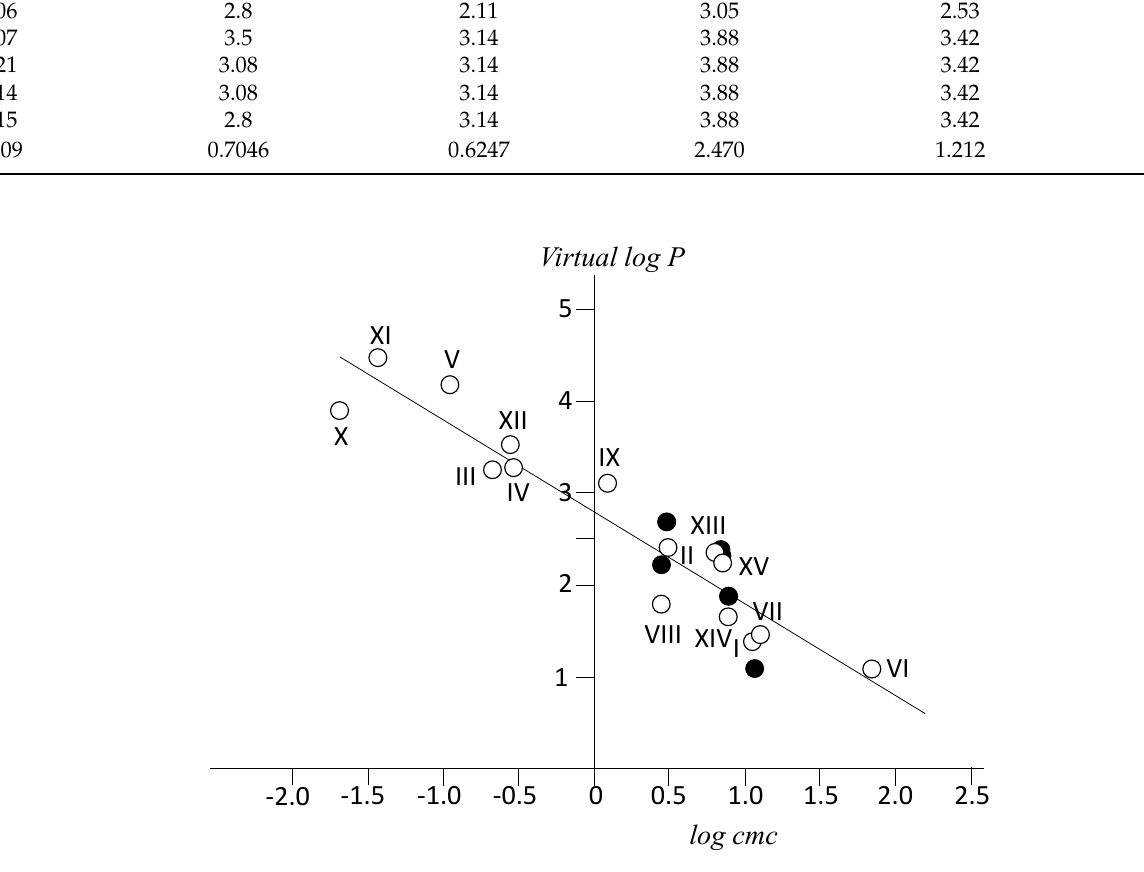
Figure 6. Calculated Virtual log P values vs. experimental log ( cmc/ mM).(Open circles) cmc values for I (NaC) and II (NaDC) from Roda et al. [50]; III (NaAdC), IV (NaAdCH2C), and V (NatbutPhC), this paper; VI (NaSuccC) and VII, NaterephtC [29]; VIII (sodium chenodeoxycholate, NaCDC) and IX (sodium obeticholate) [51]; X (NaAd(CH 2 ) 2 C) and XI (NaNAPhDC) see Supplementary information; XII (sodium litocholate), cmc in [52]. Experimental values (black circles) by Roda et al. [9]: I (NaC), II (NaDC); VIII (NaCDC); XIII (sodium ursodeoxycholate); XIV (hyocholate); XV (hyodeoxycholate). Structures are given as Supplementary Materials.